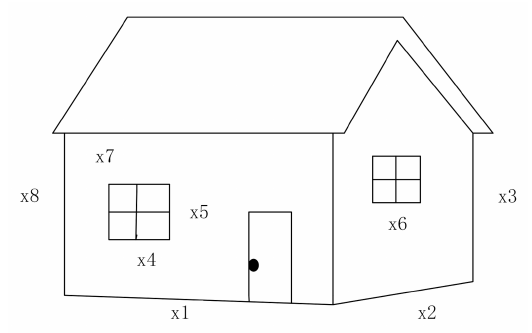
Figure 19. House heating.